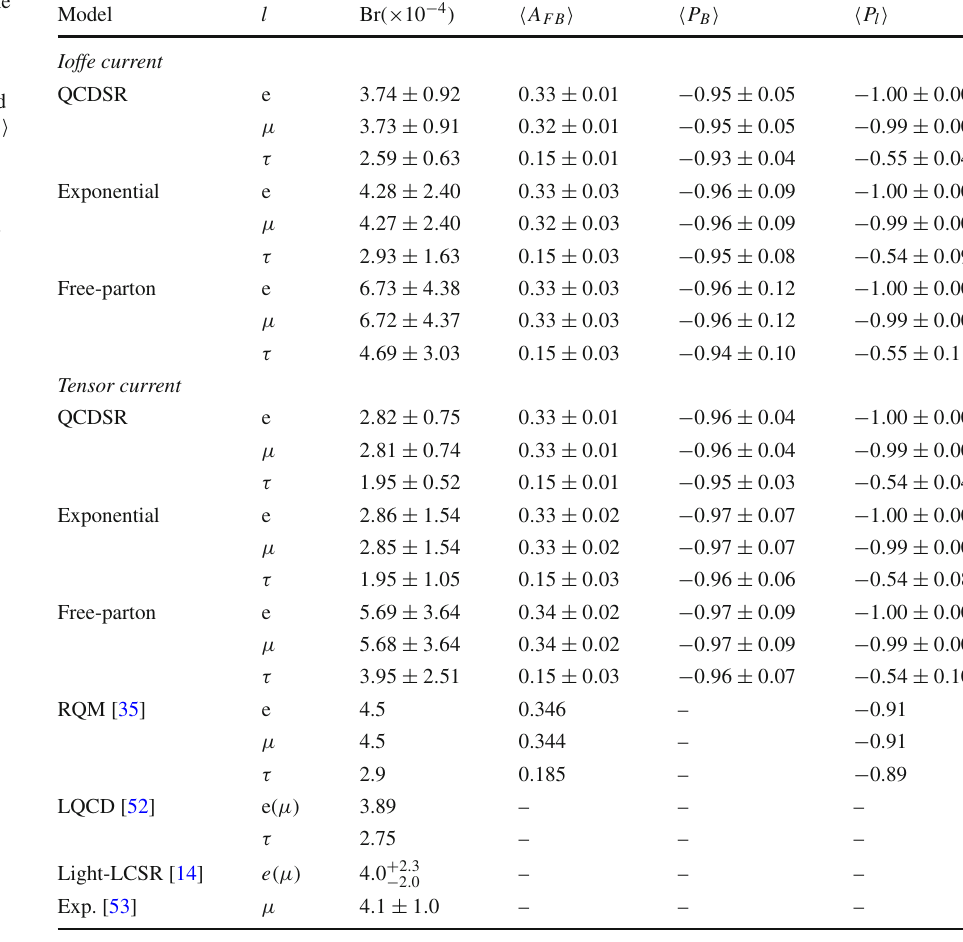
tudes can be defined